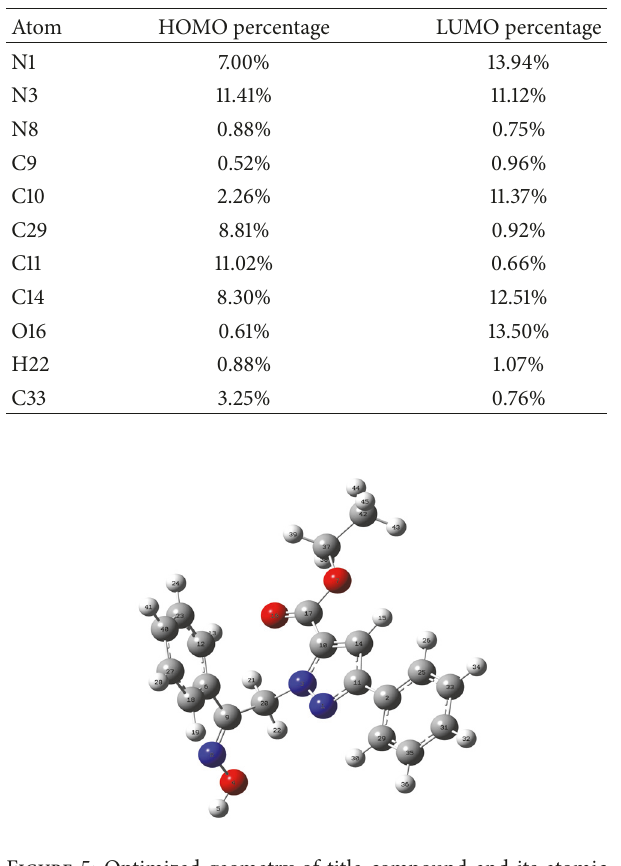
Figure 5: Optimized geometry of title compound and its atomic numbers.